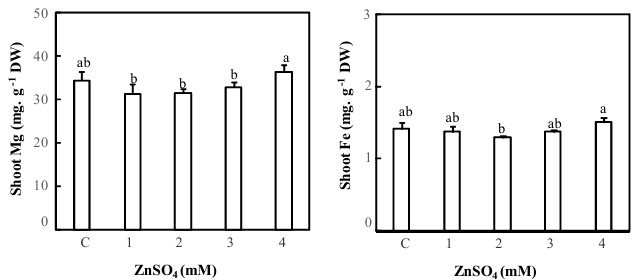
Fig. 7: Shoot content of Mg and Fe of fenugreek plants grown with differ - ent ZnSO 4 concentrations for 52 days. Values (means ± SE of three replicates) followed by the same letter are not significantly different (Duncan test, P =